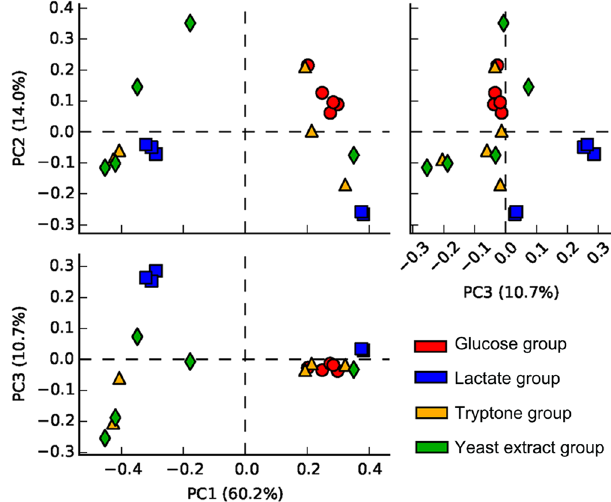
Figure 2. Principal component analysis results for the microbial